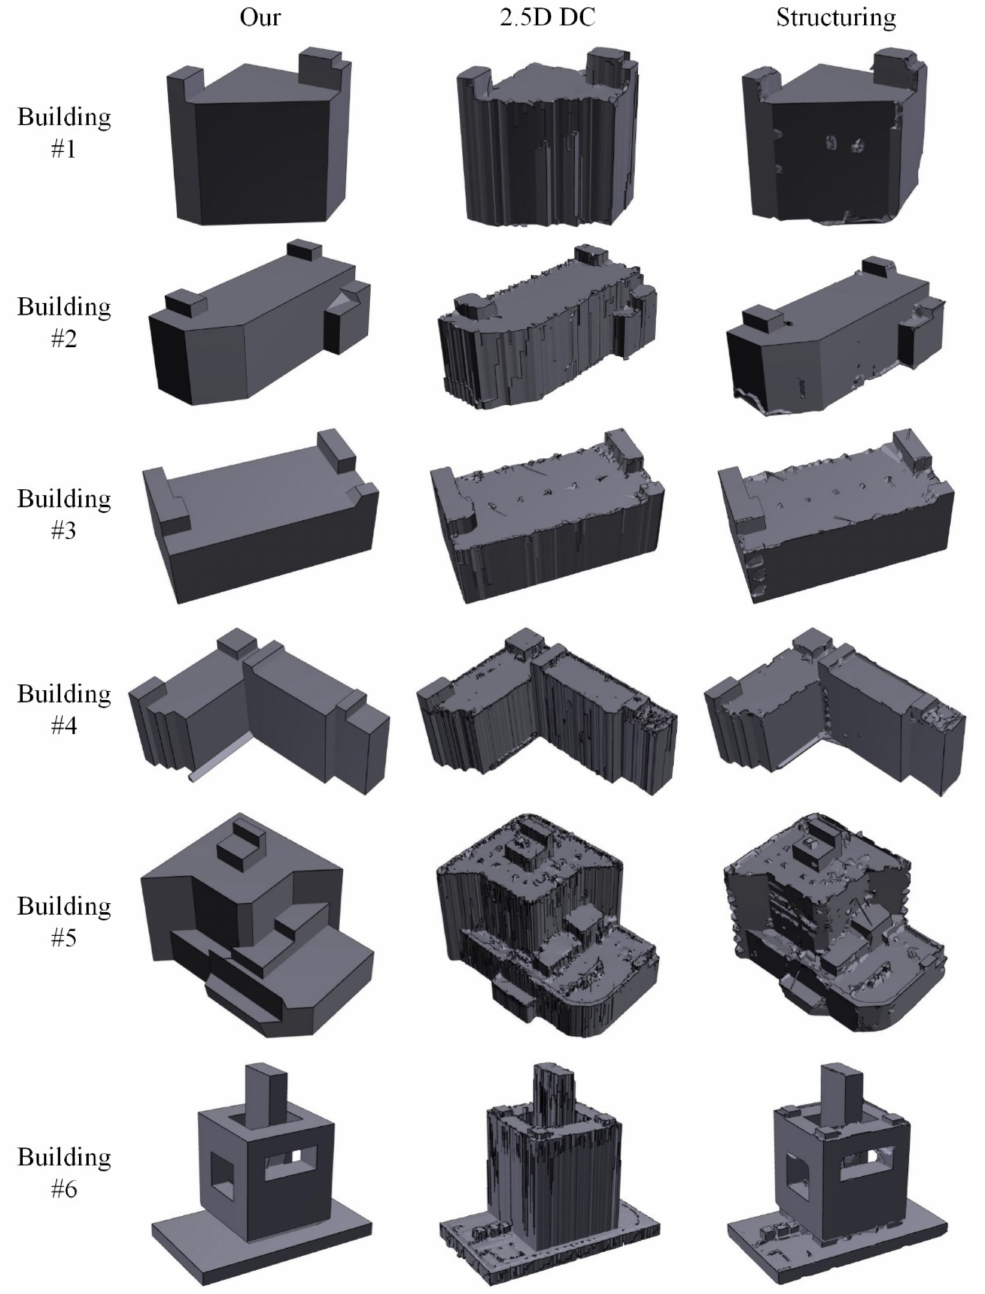
Figure 14. Comparison of models generated by our proposed method, 2.5D DC method [55], and structuring method